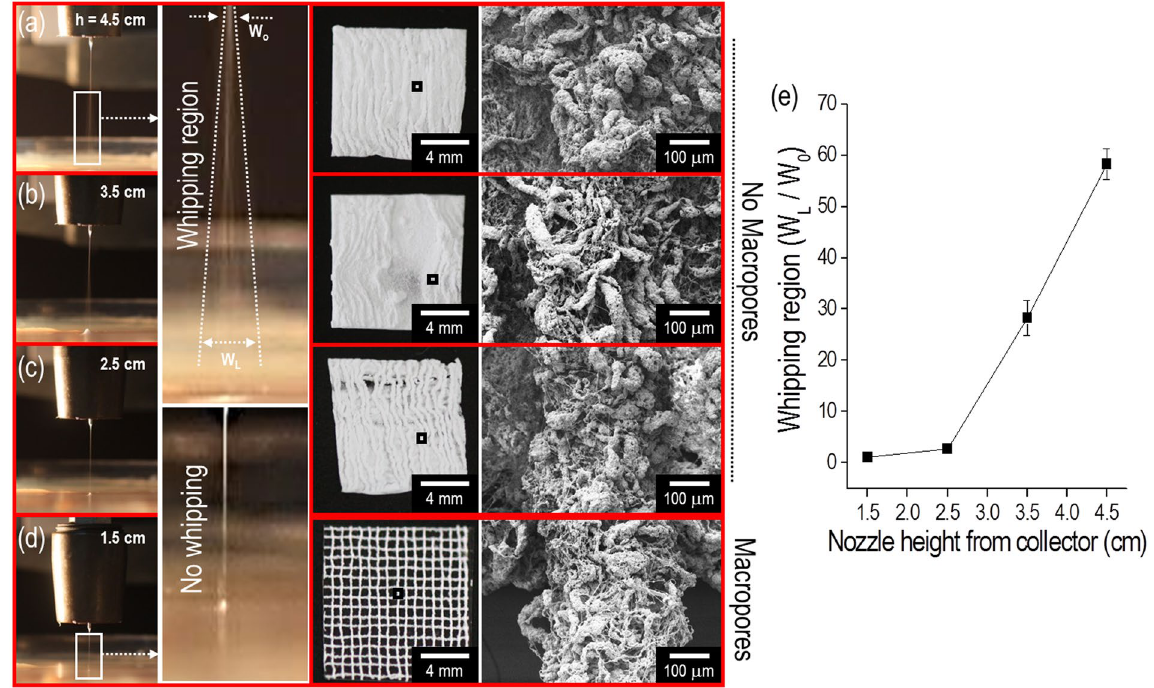
Figure 4. Effect of heights (( a ) 4.5 cm, ( b ) 3.5 cm, ( c ) 2.5 cm, and ( d ) 1.5 cm) between a nozzle tip and surface of ethanol in the EHDP process under a constant electric field (4.7 kV/cm) on the formation of a layer-by-layer mesh structure. Magnified optical images show that the whipping and non-whipping behavior were obtained for different heights. ( e ) Relative whipping region (W L /W o ) for various heights.